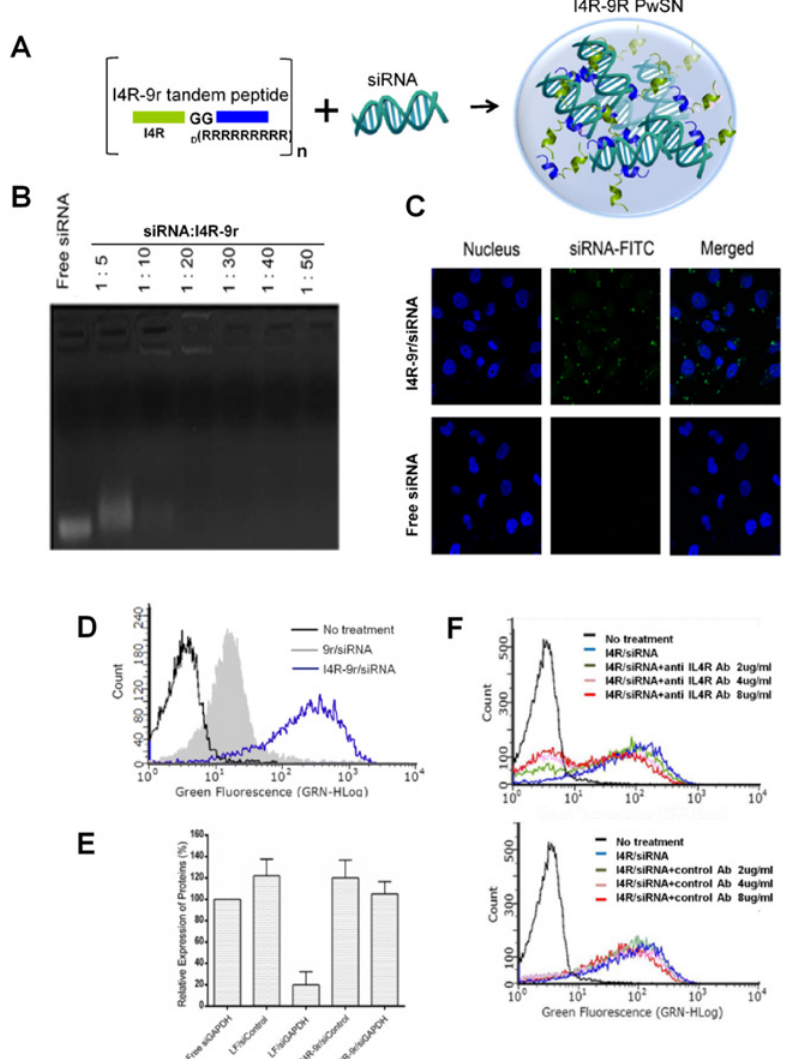
Fig 1. Design, biochemical characterization, and gene silencing activity of I4R-9r PwSN. (A) Schematic representation of the Peptide-Woven SiRNA Nanocomplex (PwSN), with siRNA noncovalently bound to I4R-9r tandem peptides composed of a tumor targeting peptide (I4R, green) and Cell penetrating peptide (9R, blue) separated by a 2-glycine spacer. (B) siRNA encapsulation by I4R-9r tandem peptides was monitored by gel retardation assay with molar ratios of 1:5 to 1:50 (siRNA-to-peptide). (C) Representative confocal microscopy images of HeLa cells treated with siRNA-FITC carried I4R-9r PwSN vs . free siRNA-FITC. (D) Representative histograms from flow cytometry for cellular uptake of I4R-9r PwSN (blue), 9r PwSN (grey), and free siRNA (black). (E) Representative histograms from flow cytometry for cellular uptake of I4R-9r PwSN (blue) vs. free siRNA (black) in the presence of indicated concentrations of anti-IL4R antibody or an IgG control. (F) HeLa cells were transfected with nanocomplexes carrying siRNA against GAPDH. The GAPDH protein expression is monitored by Western blot and presented with mean of relative immunoblot intensities. Lipofectamine was used as a positive control. The error bars represent SD from cumulative data of six independent experiments.